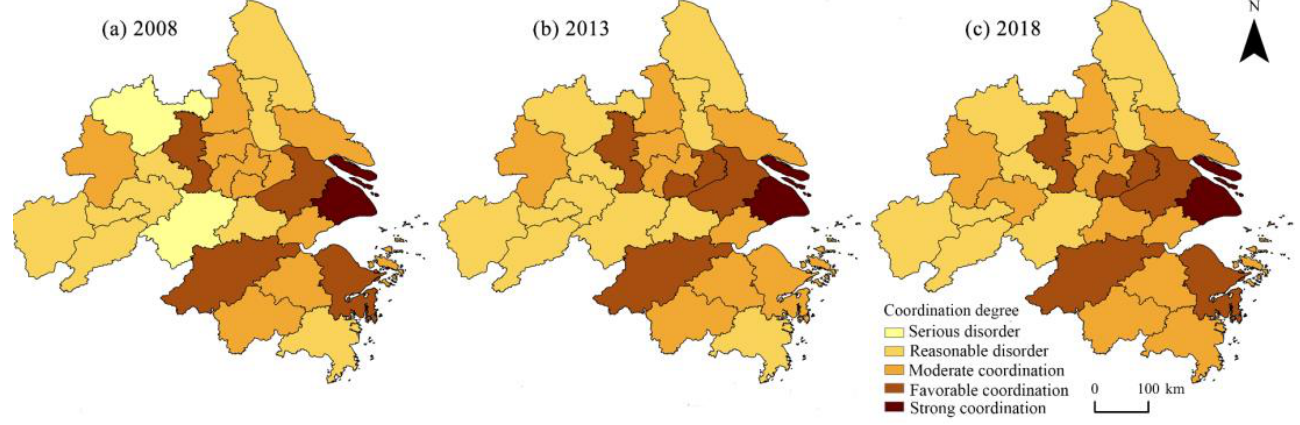
Figure 5. Coordination degree of tourism industry and urbanization in 2008 ( a ), 2013 ( b ), and 2018 ( c